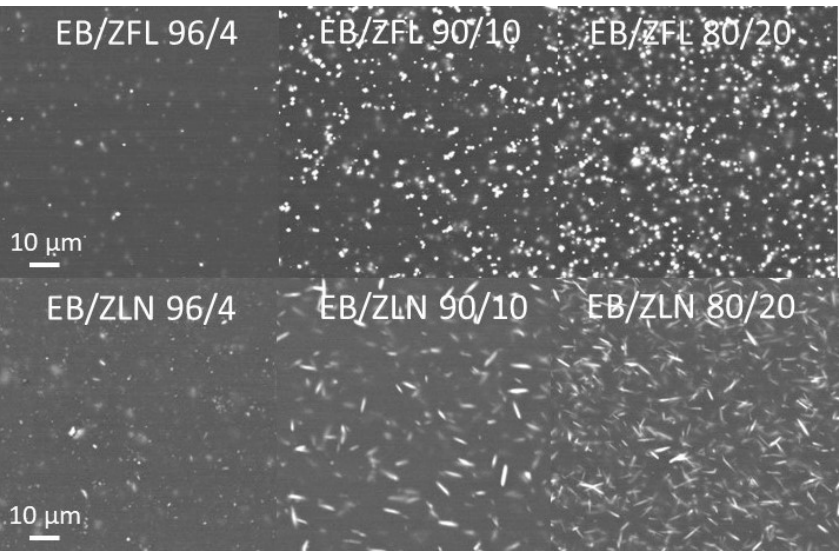
Figure 10. SEM micrographs obtained using backscattered electrons of EB/ZFL and EB/ZLN 96/4, 90/10, and 80/20 surfaces.